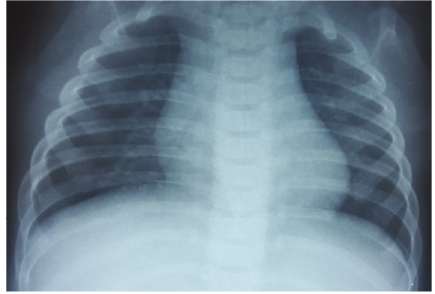
Figure 4: Normal chest X-ray on